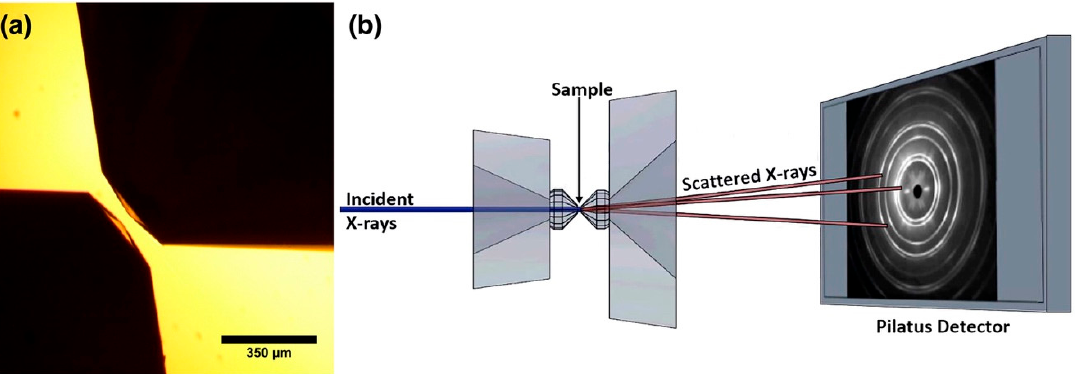
Figure 1. ( a ) Microscope image of two diamond anvils with an opposed configuration within a diamond anvil cell (DAC). Sample placement is centered on the culet, or flat tip, of one of the anvils. ( b ) Schematic of the DAC within experimental settings. Incident X-rays are propagated along the axis of compression and collected on a Pilatus 1M detector after sample scattering.